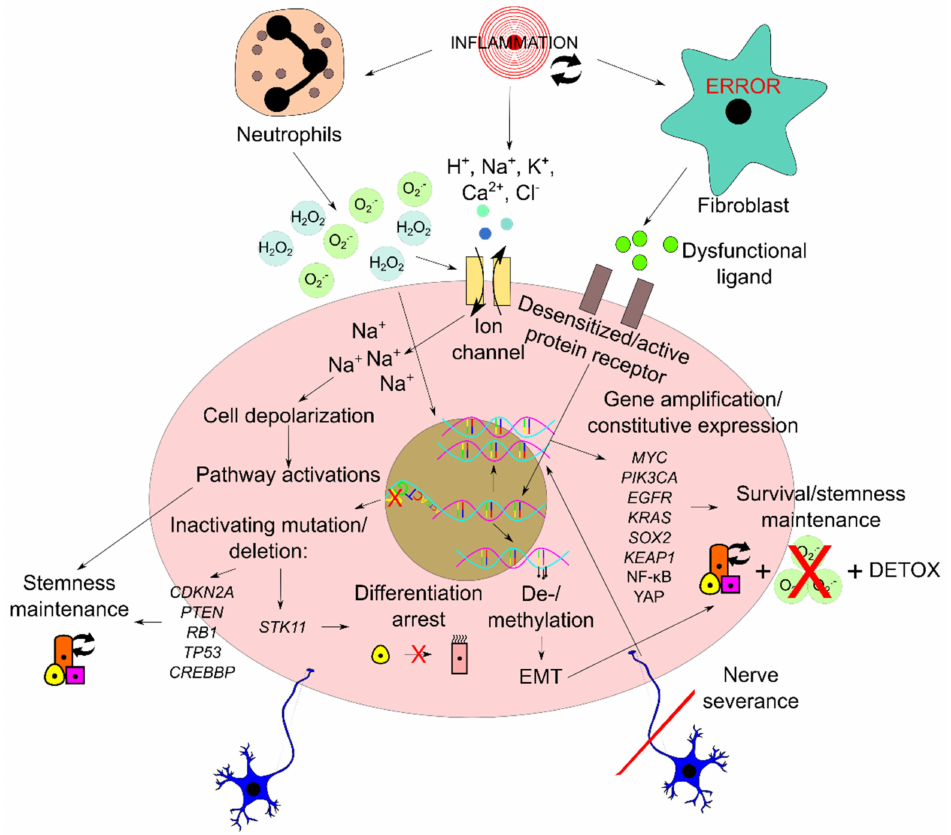
Figure 3. Schematic diagram depicting various molecular aberrations and dysregulations supporting the development of CSCs. The microenvironmental components are influenced by the recurrently induced inflammation and, in turn, feed the negatively affected morphostatic instructions to epithelial cells leading to aberrant changes of genetic and epigenetic components. This consequently enables favorable behavioral changes that facilitate the cellular transformation of CSCs. EMT, epithelial-to-mesenchymal